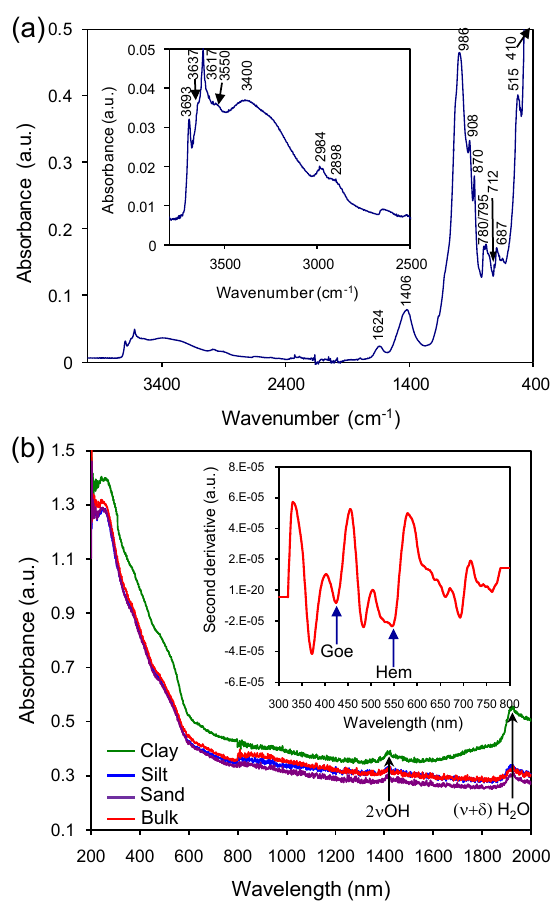
Figure 11. Spectral features of Saharan dust. (a) ATR-FTIR spec- trum of dust. The inset shows absorbance values for high wavenum- bers (IR spectral region with lower wavelength values: 2.6–4µm). Wavenumbers of main absorbance bands are indicated; (b) UV- Vis-NIR spectra of bulk Saharan dust, and its three size fractions (clay, silt and sand).The inset shows the second derivative of the ab- sorbance spectrum of the bulk sample. Blue arrows show the bands used for the calculation of goethite (Goe) and hematite (Hem) rela- tive contents in the bulk